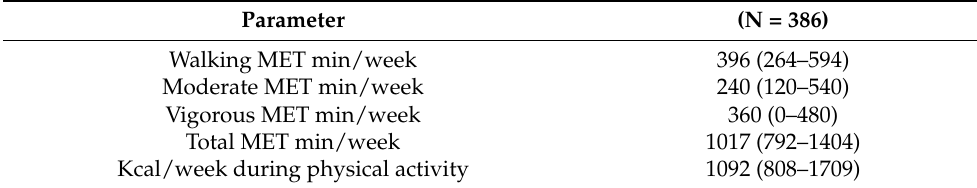
Table 2. International Physical Activity Questionnaire (IPAQ) results.